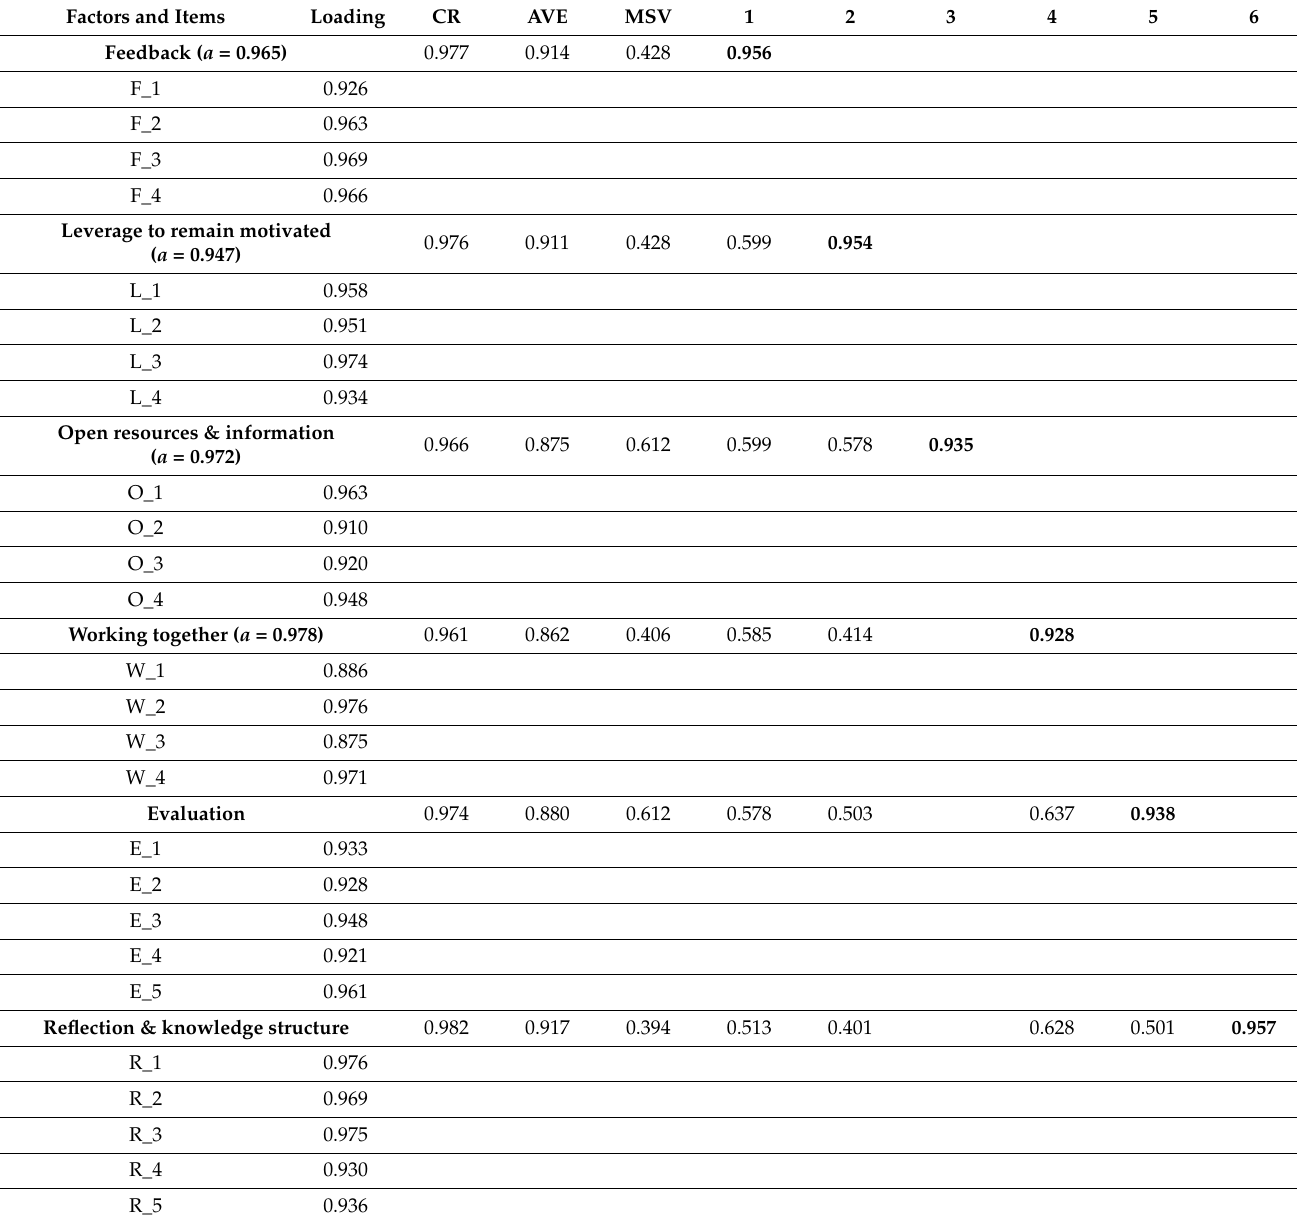
Table 2. Discriminant and convergent validity of the measurement